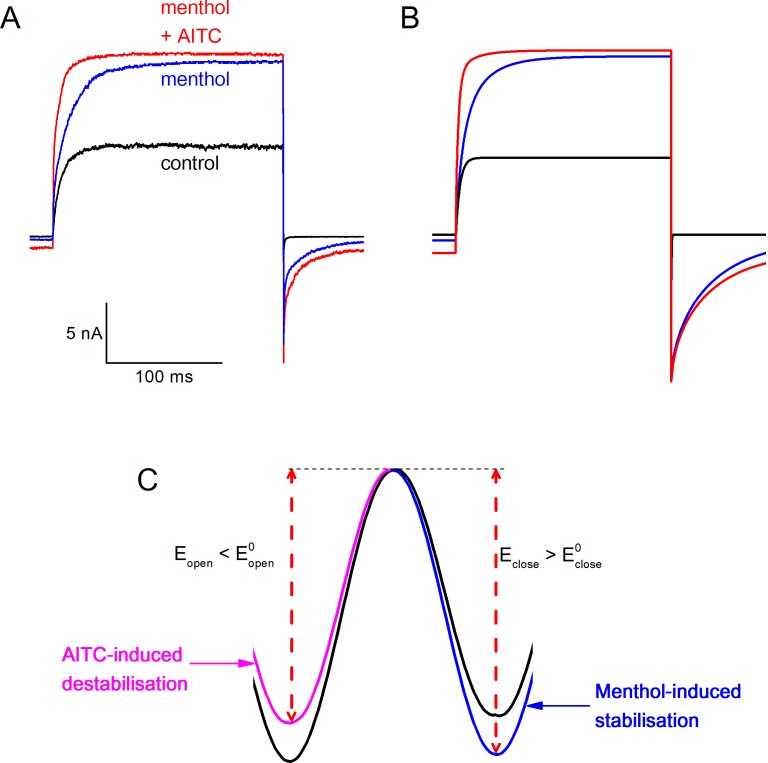
Combining Type I and Type II agonists.(A) Combined effect of menthol and AITC on TRPM8 gating kinetics, using the voltage protocol shown in Figure 4A. (B) Model simulation of the combined effect menthol and AITC. To obtain these traces, the effect of AITC was modeled as a fixed decrease of ΔG0mVα†. (C) Energy profiles upon simultaneous binding of Type I (top) and Type II (bottom) ligands.